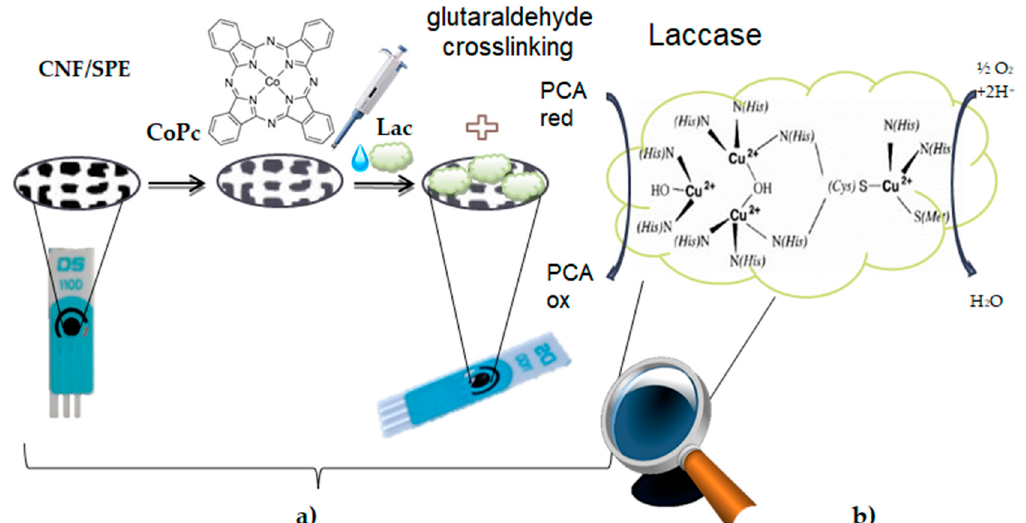
Figure 14. ( a ) Preparation process of the laccase-based biosensor on the support of a screen-printed electrode based on cobalt phthalocyanine-modified carbon nanofibers. ( b ) The enzymatic oxidation mechanism of PCA in the presence of laccase.